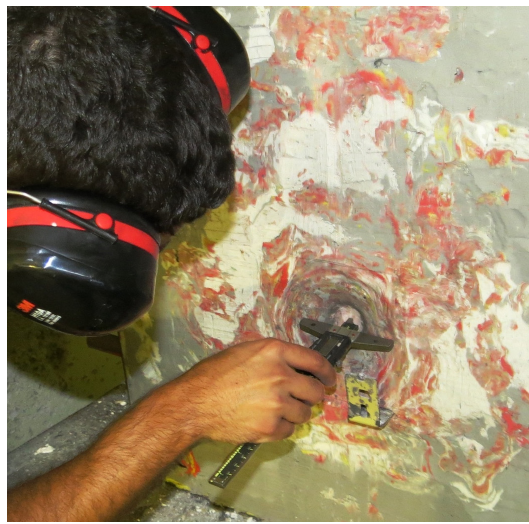
Figure 3. Measurement of the indentation in the clay witness caused by the projectile impact.